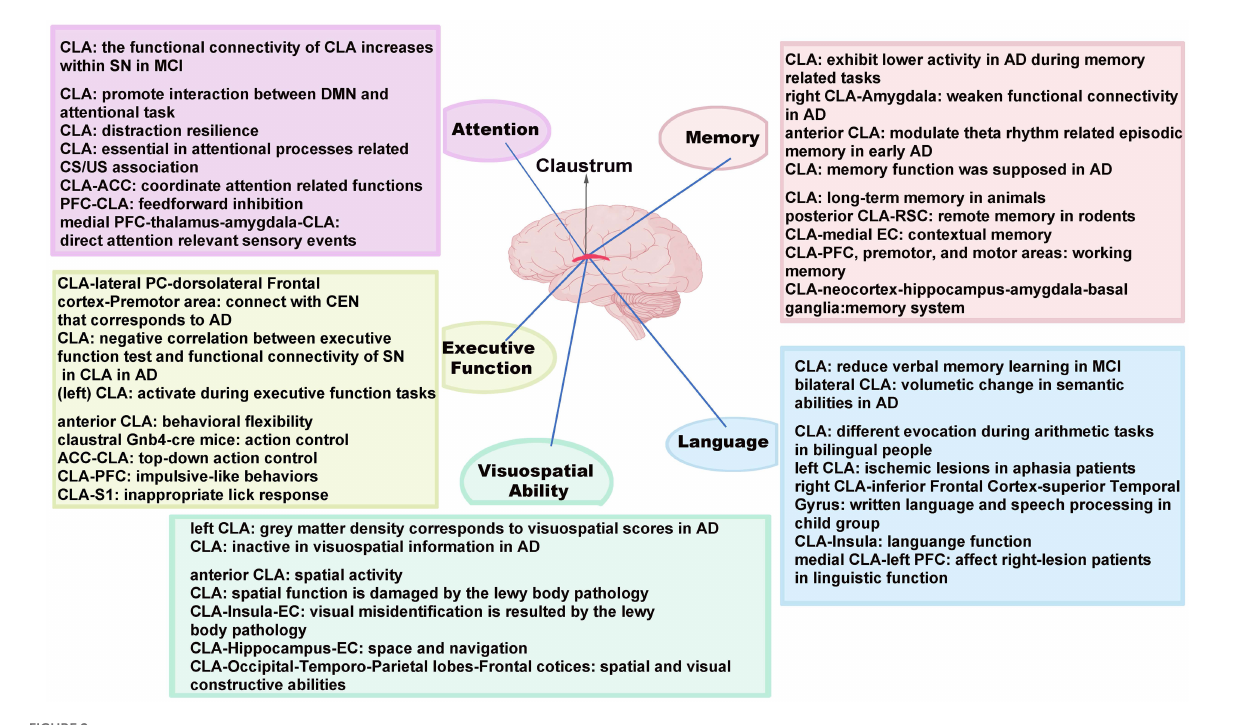
FIGURE 2 Major cognitive functions and the underlying mechanisms mediated by the CLA with its related circuits in AD. SN, salience network; MCI, mild cognitive impairment; DMN, default mode network; CS, conditioned stimulus; US, unconditioned stimulus; CEN, central executive network; ACC, anterior cingulate cortex; PFC, prefrontal cortex; S1, primary somatosensory cortex; PC, parietal cortex; EC, entorhinal cortex; RSC, retrosplenial